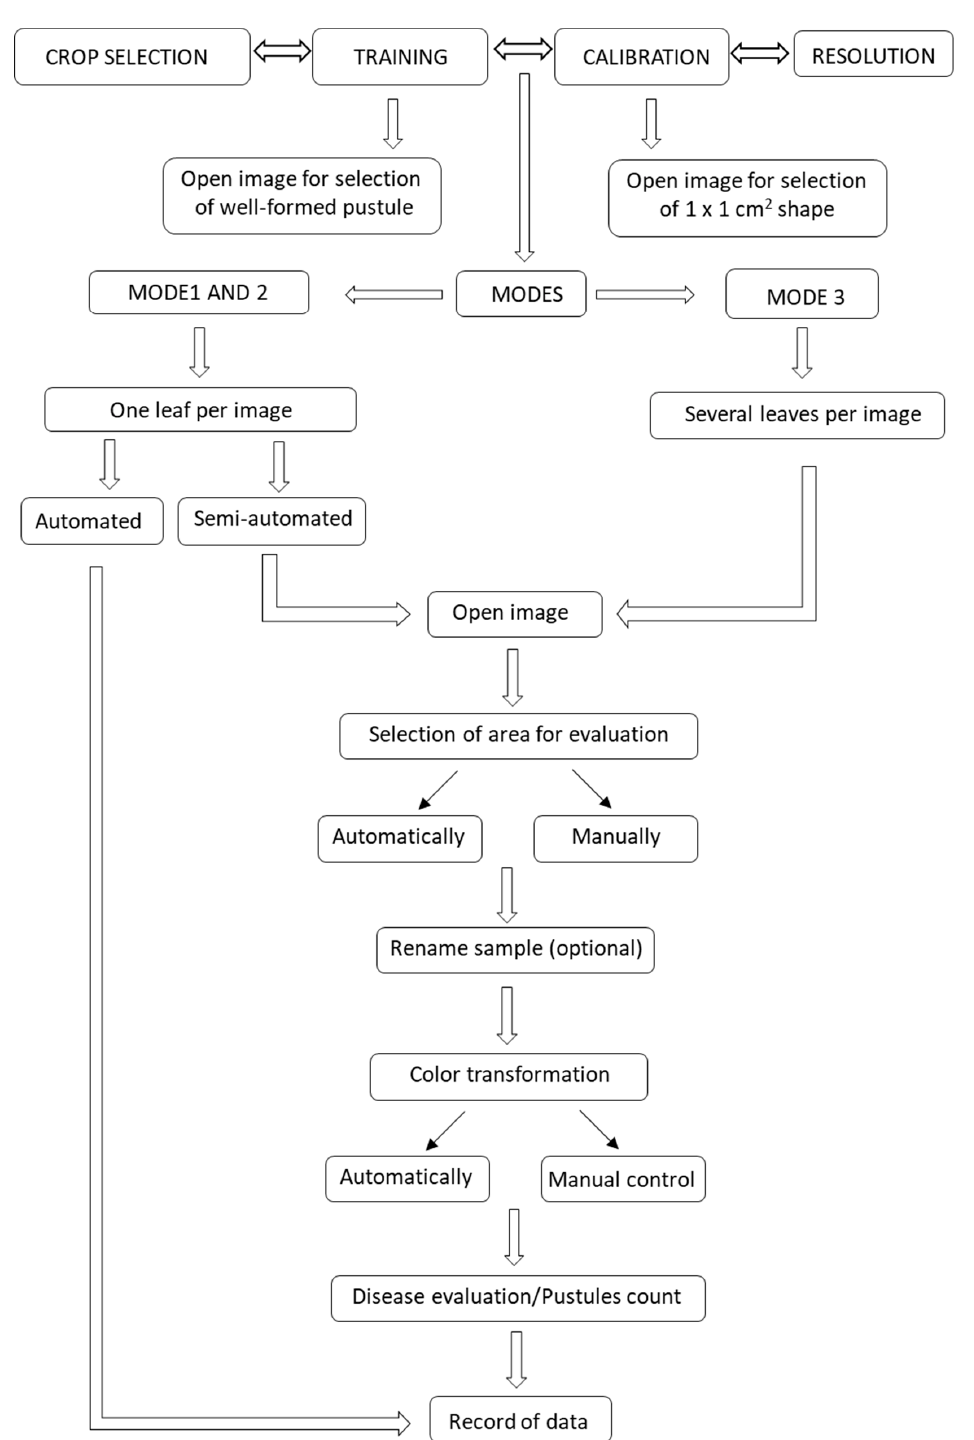
Figure 1. Scheme of the process followed by the Robust, User-Friendly Script Tool (RUST) to evaluate and record rust diseases.